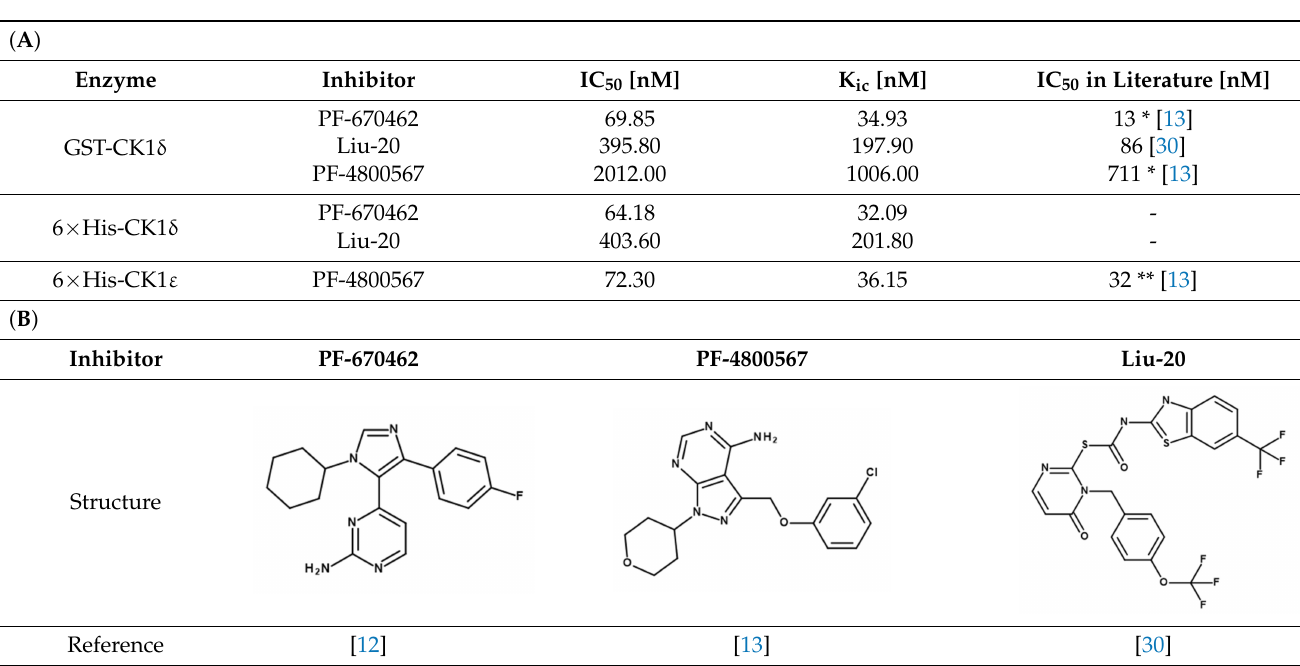
Table 2. Overview of the tested ( A ) enzymes and ( B ) inhibitors as well as the determined IC 50 values and the resulting K ic